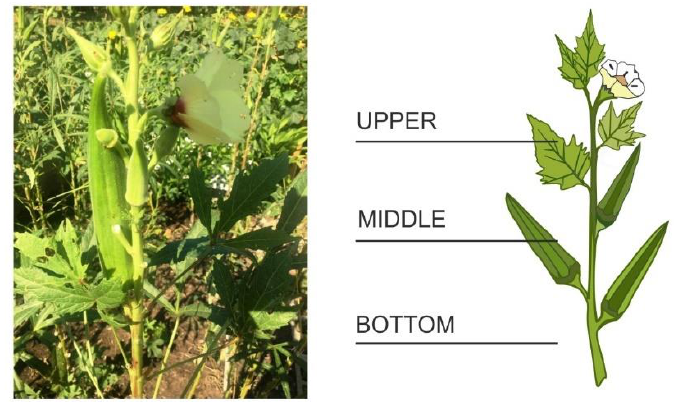
Figure 1. The view of an okra plant stem.